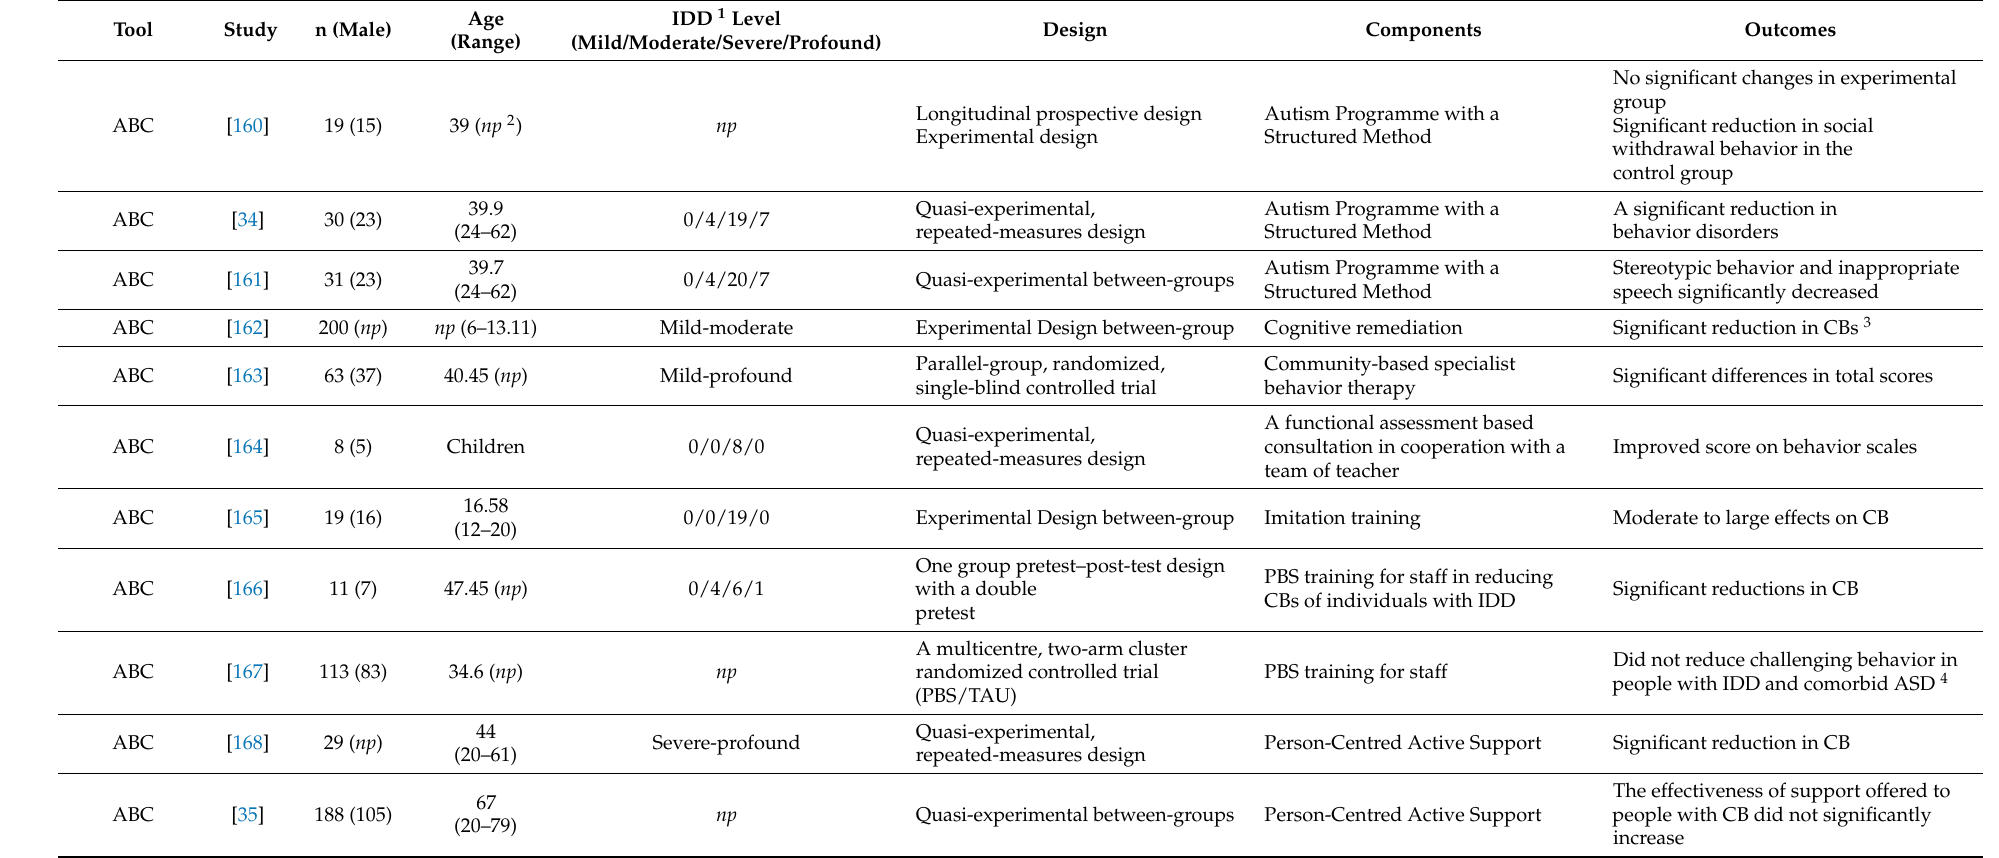
Table 4. Intervention studies included in the